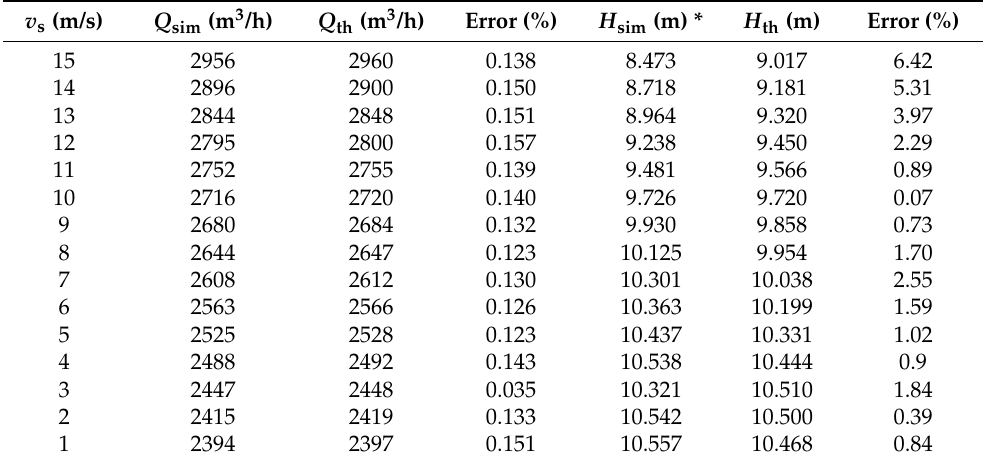
Table 2. Comparison between simulated and theoretical flow rate or head in different conditions. v s (m/s) Q sim (m 3 /h) Q th (m 3 /h) Error (%) H sim (m)